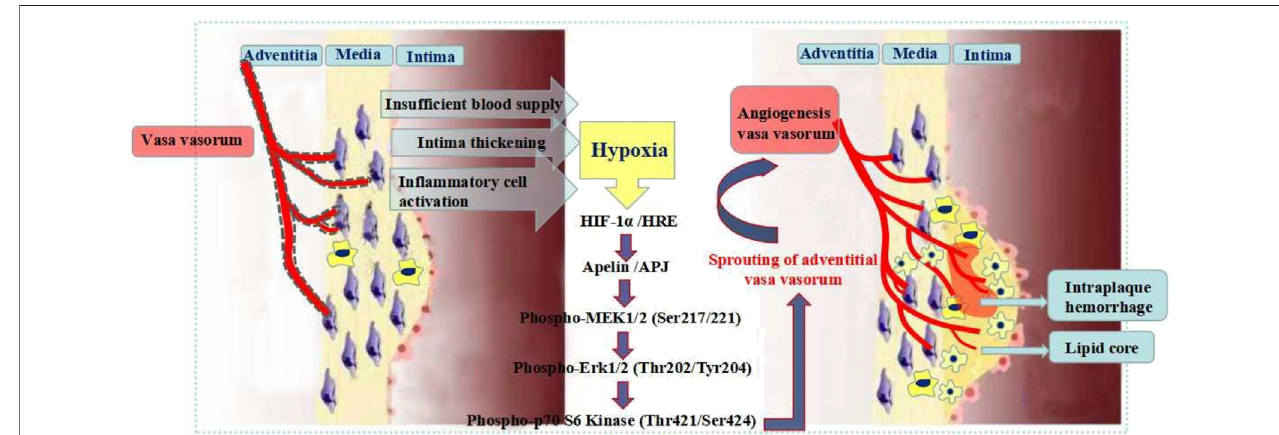
FIGURE10| MechanismofAng-1/Tiesignalingpathwaymaintainingthe vasa vasorum maturation.